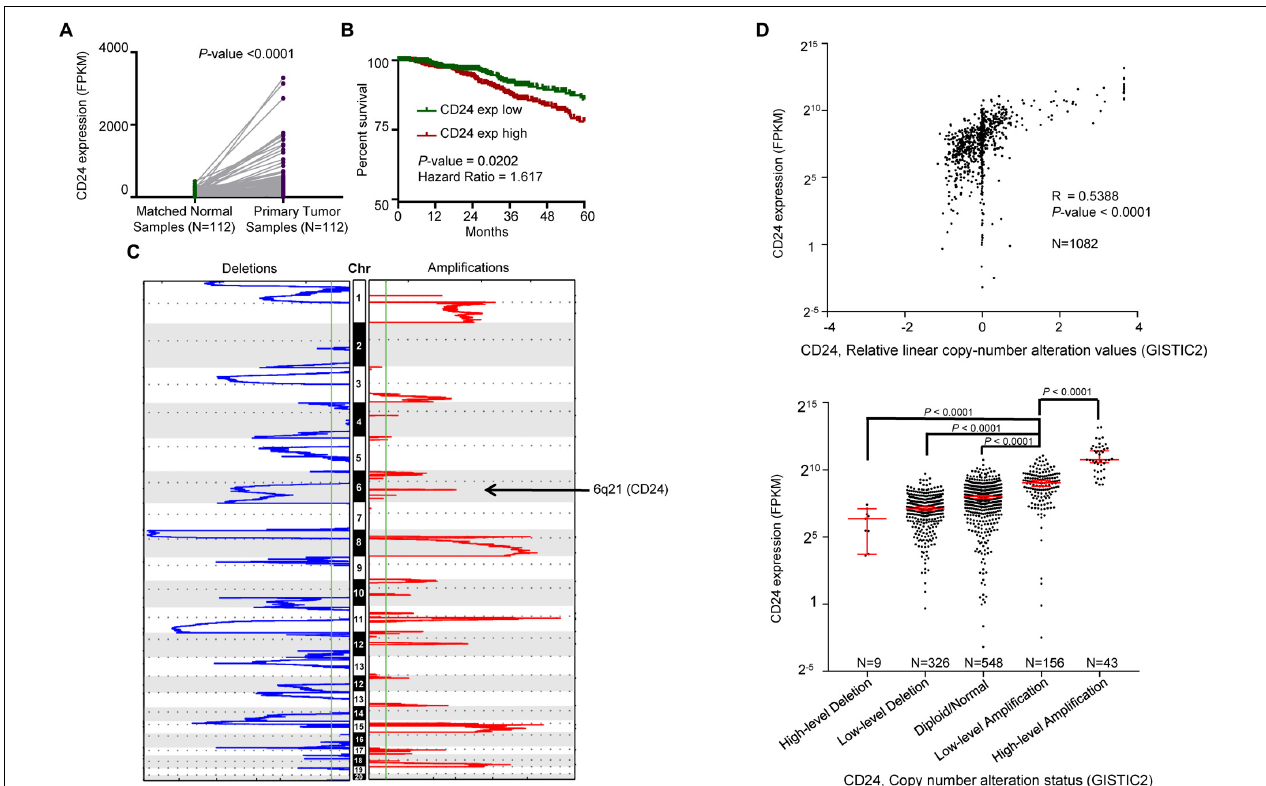
FIGURE 2 | Correlation between CD24 copy number alterations and mRNA expression. (A) Change of CD24 mRNA expression between tumor samples and matched normal samples from TCGA BRCA studies ( N = 112). (B) Kaplan–Meier survival curve comparing the high ( N = 533) and low ( N = 532) expression value of CD24 (determined by the median value) for the TCGA BRCA patient cohort. (C) GISTIC heat map showing genomic copy-number profiles from TCGA BRCA studies. Gain (red) and loss (blue) of each peak are shown. Regions of copy-number gain (6q21) were highlighted. (D) Scatter plot (top) and dot plot (bottom) showing the strong positive correlation between CD24 copy number values defined by GISTIC2 approach and mRNA expression values quantified by FPKM ( N = 1082). GISTIC2 method stratified the CD24 copy number values into five categories: high-level copy number deletion ( N = 9), low-level copy number deletion ( N = 326), diploid normal copy ( N = 548), low-level copy number amplification ( N = 156), and high-level copy number amplification ( N = 43). Statistical significance was determined by the Paired t -test in panel (A) , log-rank test in panel (B) and the One-way ANOVA in panel (D) (bottom). The Spearman coefficient of correlation (R) and significance in panel (D) (top) was determined by linear